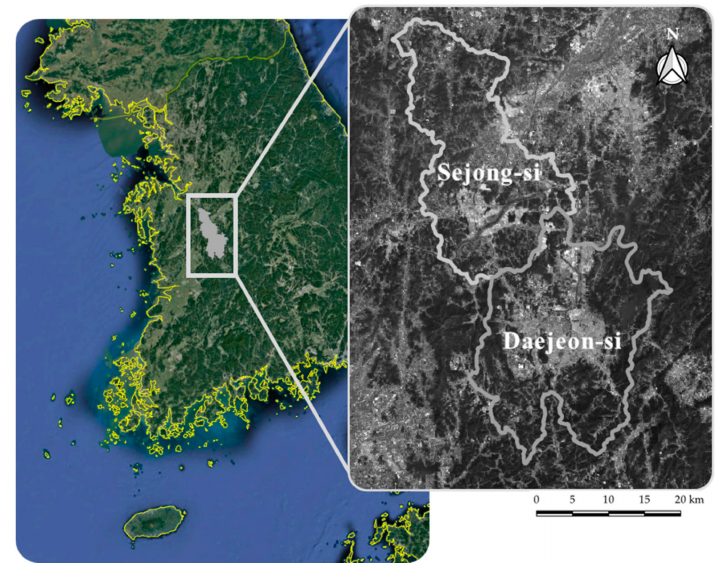
Figure 1. Location of Daejeon and Sejong depicted with Google map and Sentinel-2 images (band 2 image acquired on